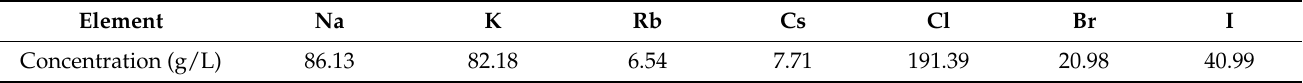
Table 1. Concentrations of elements in the feed